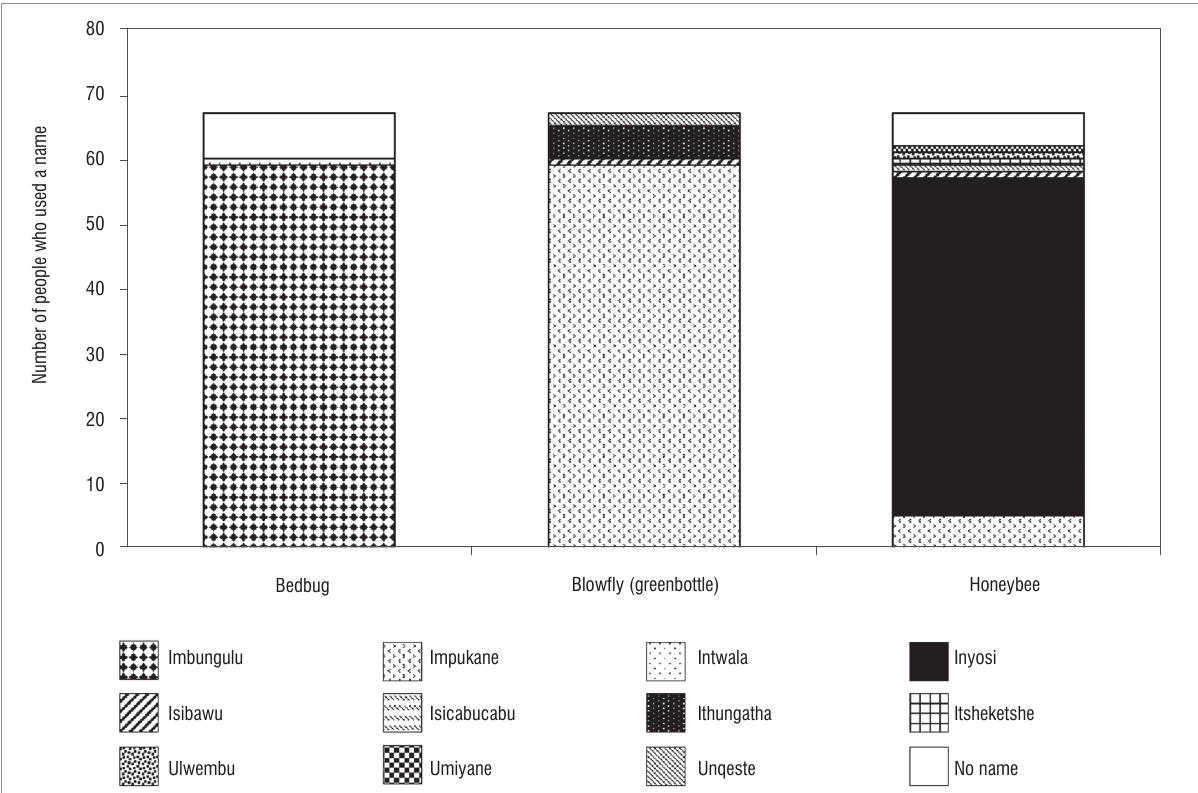
Figure 5: Examples of insects that have one cosmopolitan name that is used consistently across all